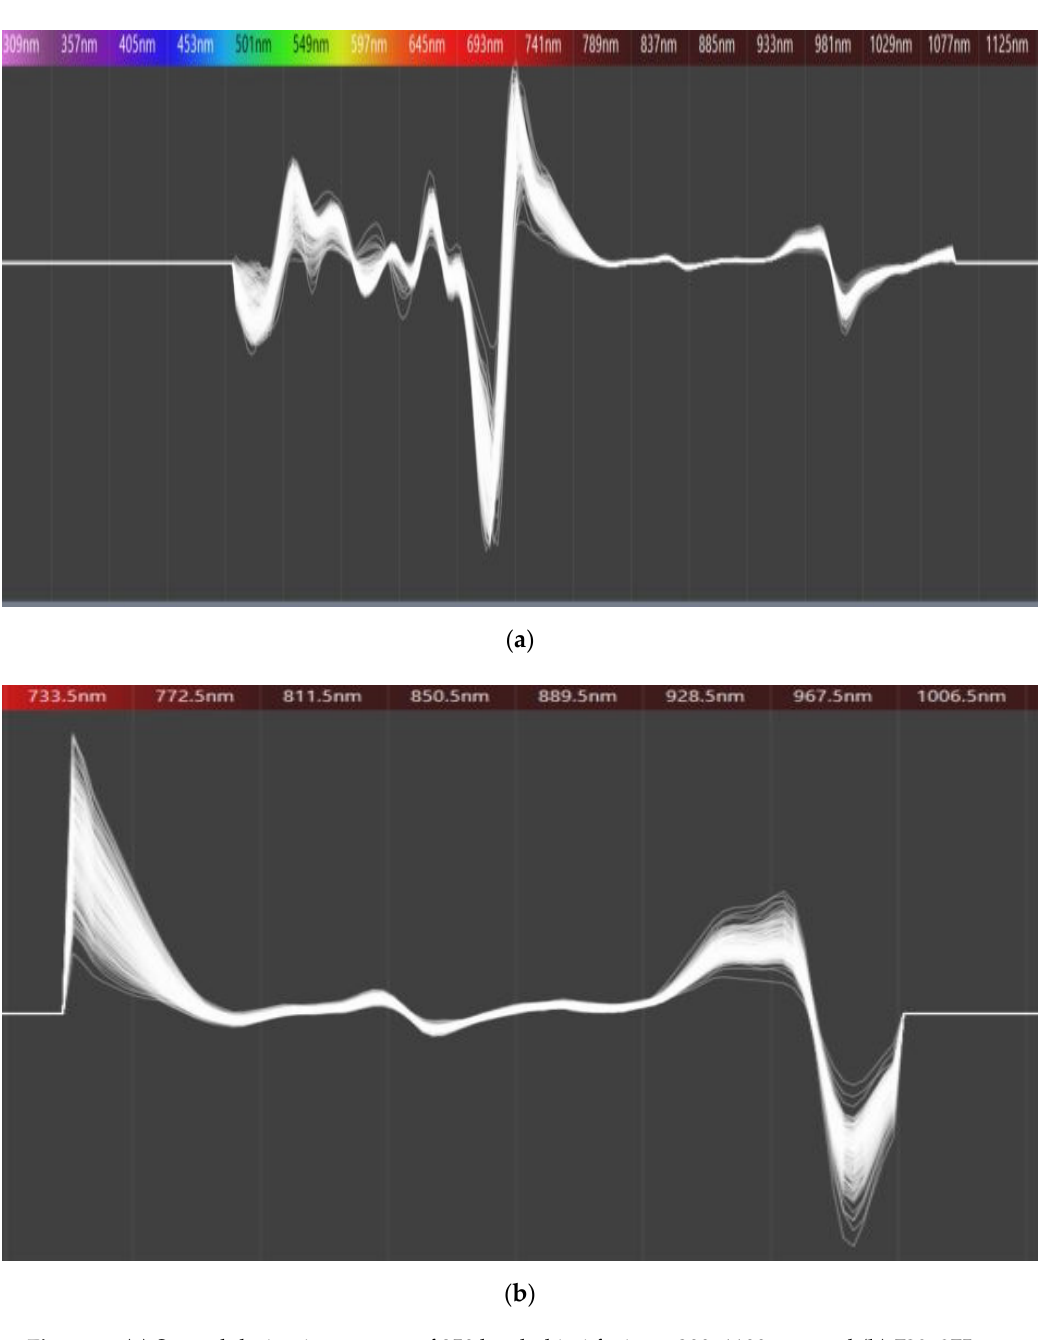
Figure 2. ( a ) Second derivative spectra of 350 hardy kiwi fruits at 300–1100 nm; and ( b ) 729–975 nm.